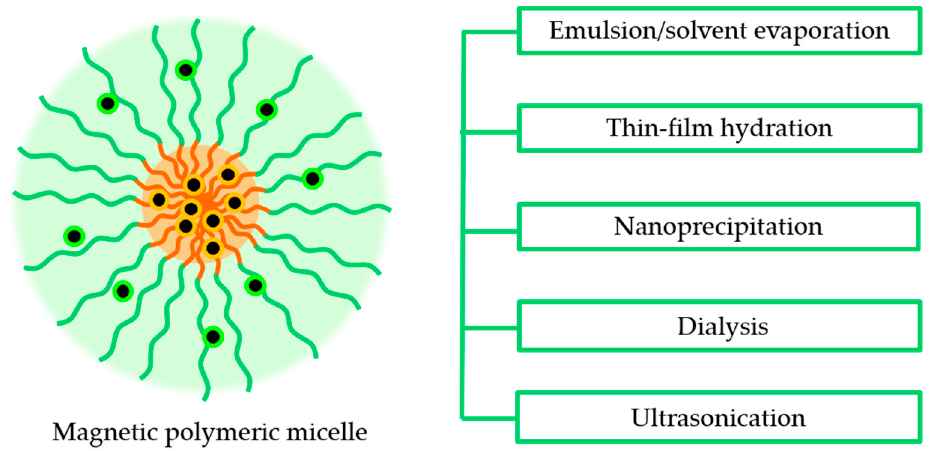
Figure 3. Methods for the production of magnetic polymeric